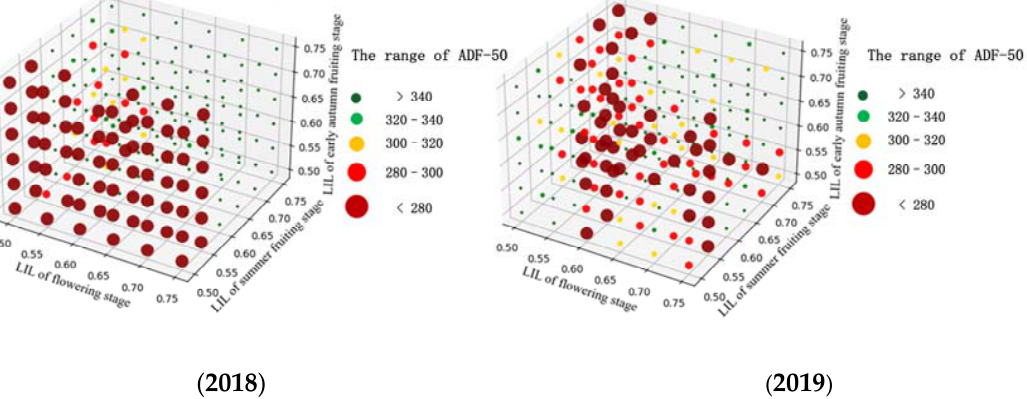
Figure 8. Scatterplot of relationship between lower irrigation limit and ADF-50 at different growth stages.